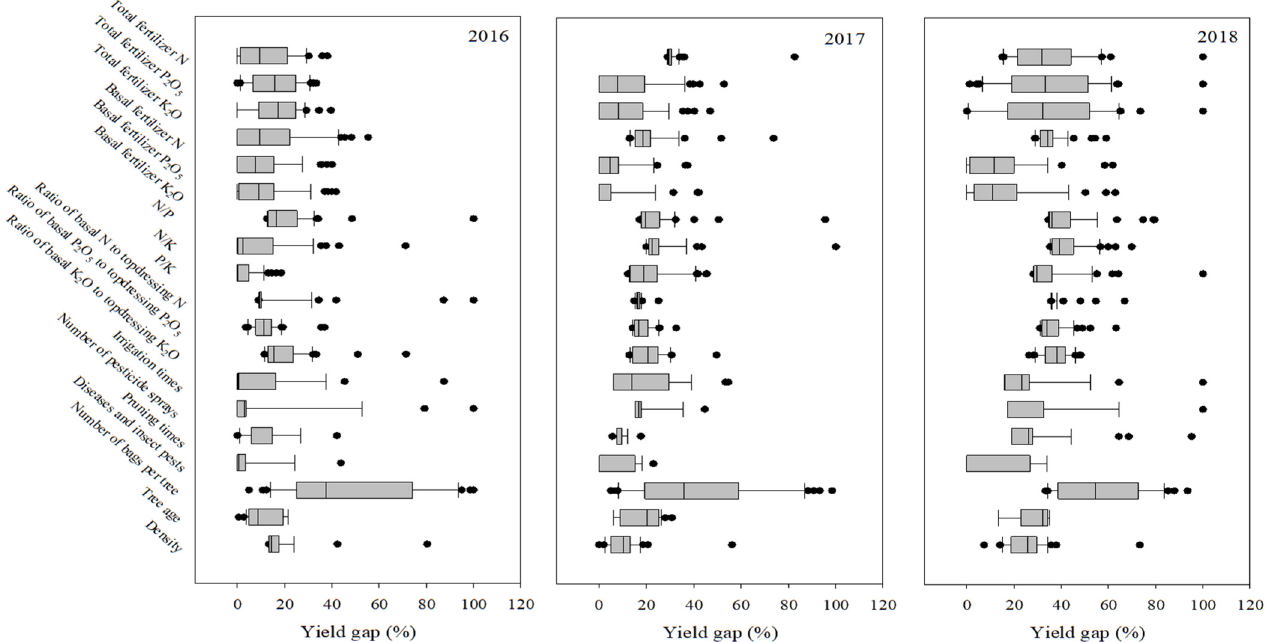
Figure 6. Explained yield gap for management limiting factors, expressed as a percentage of the attained maximum yield in 2016–2018, for Beiquan Village, Hebei, China. The box boundaries indicate upper and lower quartiles, the whisker caps indicate 90th and 10th percentiles, and the points indicate the outliers.